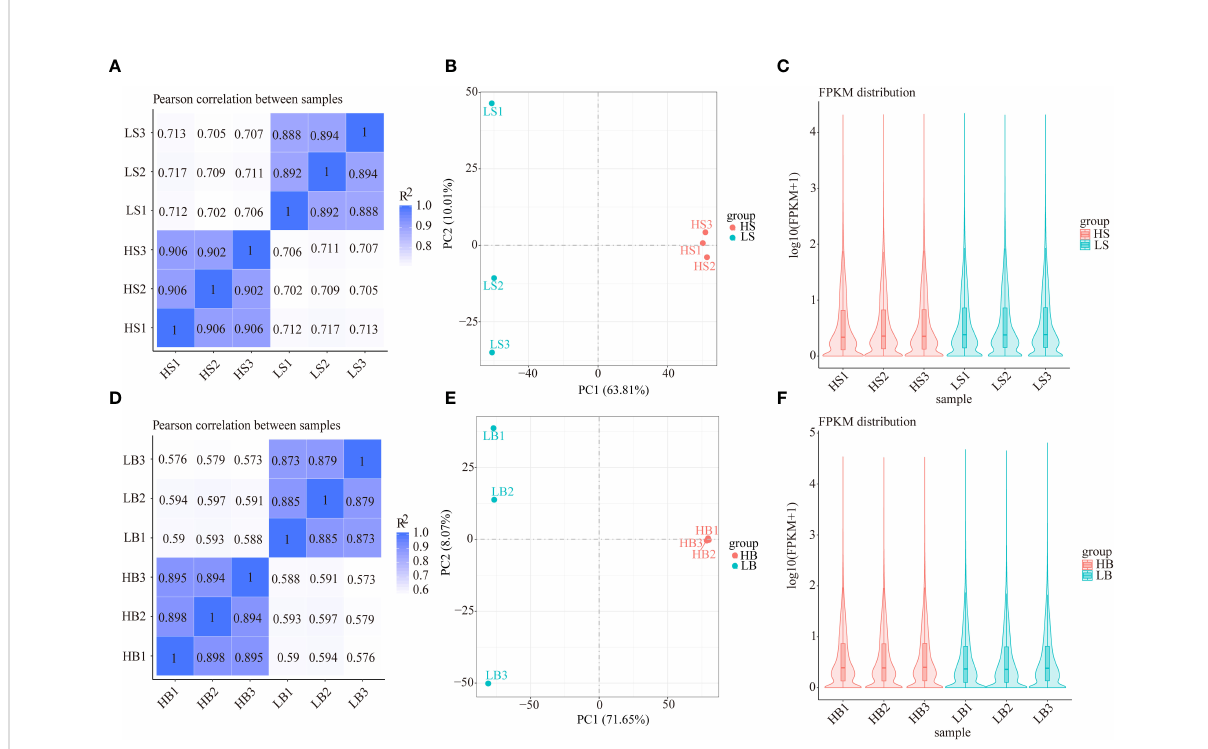
FIGURE 4 Gene expression analysis of H. ammodendron and H. persicum in an arid environment. (A, D) are heat maps of the correlation coef fi cients of the gene expression of H. ammodendron and H. persicum in humid and arid environments. The abscissa is the log10(FPKM+1) of sample 1; the ordinate is the log10(FPKM+1) of sample 2. R 2 : The square of the Pearson correlation coef fi cient. (B, E) are the PCA score maps of the transcriptome data of the two species ’ samples. (C, F) are the comparison charts of the gene expression levels of the two species in humid and arid environments. The abscissa is the sample name, and the ordinate is